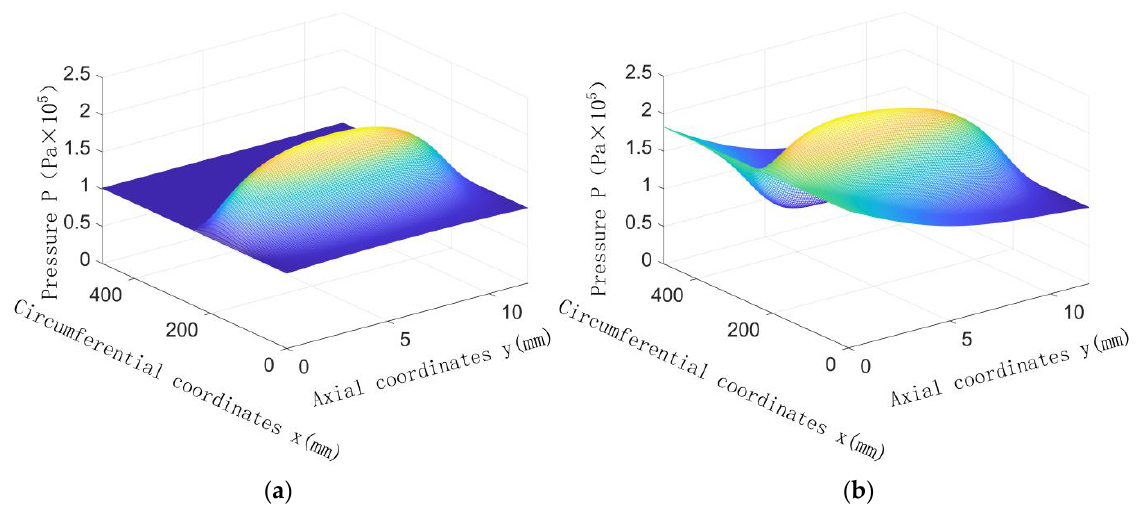
Figure 5. Mode 1 (codirection rotation): ( a ) without inlet pressure difference; ( b ) with inlet pressure difference.